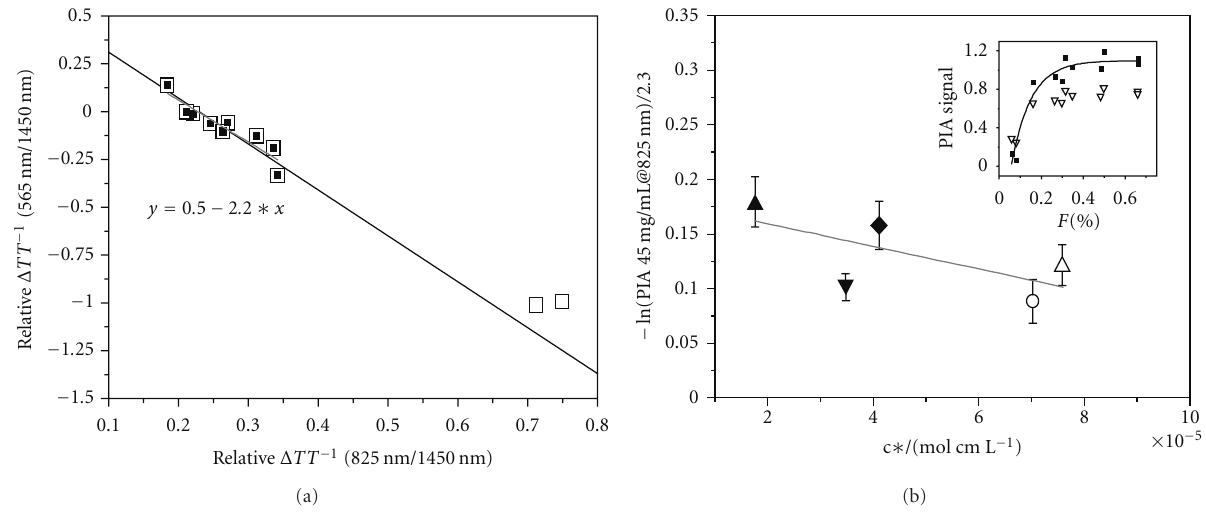
Figure 7: (a) Δ TT − 1 signal intensities relative to the peak at 1450 nm, for 565nm (( Δ T 565nm T 565nm − 1 )/( Δ T 1450nm T 1450nm − 1 ), y -axis) compared to 825nm (( Δ T 825nm T 825nm − 1 )/( Δ T 1450nm T 1450nm − 1 ), x -axis). The solid line is a linear fit to the data, excluding the highly scattering points at the lowest concentration: y = − 2 . 2 x + 0 . 5. The dashed line shows y = − 2 . 4 x + 0 . 55. (b) The ln(relative PIA signal at 825 nm)/2.3 is plotted against the concentration times length (molcm L − 1 ). The spiro-MeOTAD concentrations are 45 ( (cid:3) ), 90 ( (cid:4) ), 100 ( (cid:9) ) mgmL − 1 ; 180 ( (cid:6) ) mgmL − 1 ; 200 ( (cid:8) ) mgmL − 1 . Inset: Δ TT − 1 signal intensity relative to the peak at 1450nm, for 825 nm (( Δ T 825nm T 825nm − 1 )/( Δ T 1450nm T 1450nm − 1 ), (cid:2) ) and for 565 nm (( Δ T 565nm T 565nm − 1 )/( Δ T 1450nm T 1450nm − 1 ), ( (cid:10) ) compared to the filling fraction obtained in Section 2.1. The data are fitted with exponential functions: y = − 2 ∗ exp( − x/ 0 . 1) + 1 . 1 (solid line) and − 1 ∗ exp( − x/ 0 . 1) + 0 .